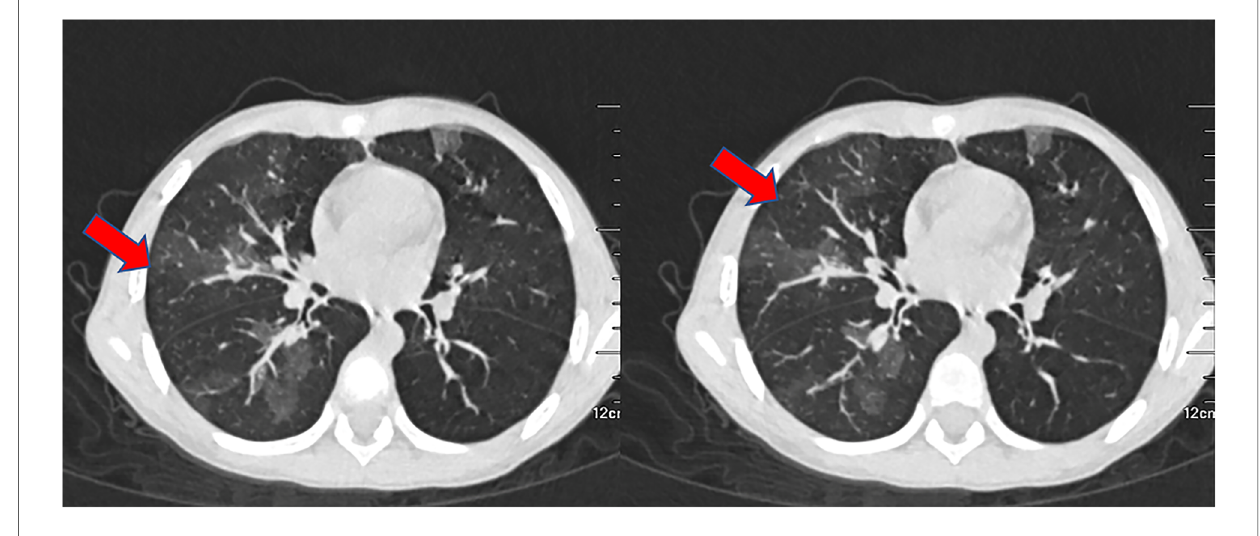
FIGURE 4 The CT scan of the chest performed 43 days after admission displayed widespread mosaic